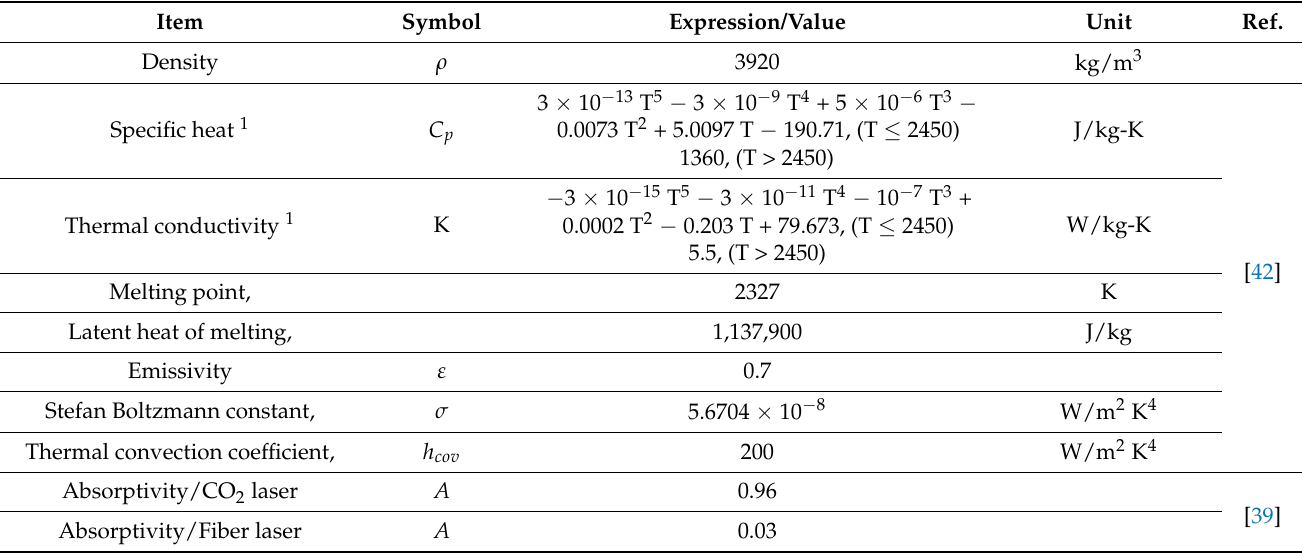
Figure 1. Initial and boundary conditions considered during the model development. Table 1. Alumina material properties as a function of temperature and other